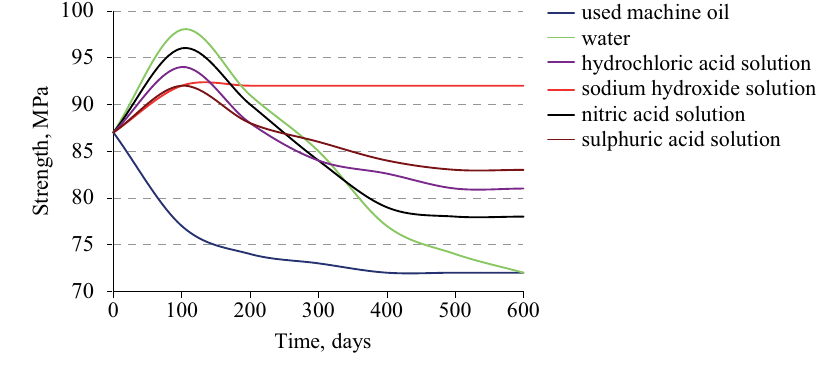
Figure 2. The strength change of the acryl composition samples under the aggressive medium